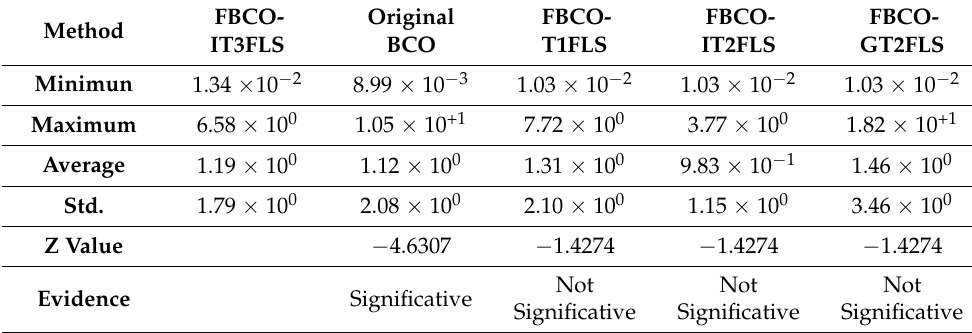
Table 4. Statistical test results for proposal FBCO-IT3FLS without Perturbation.